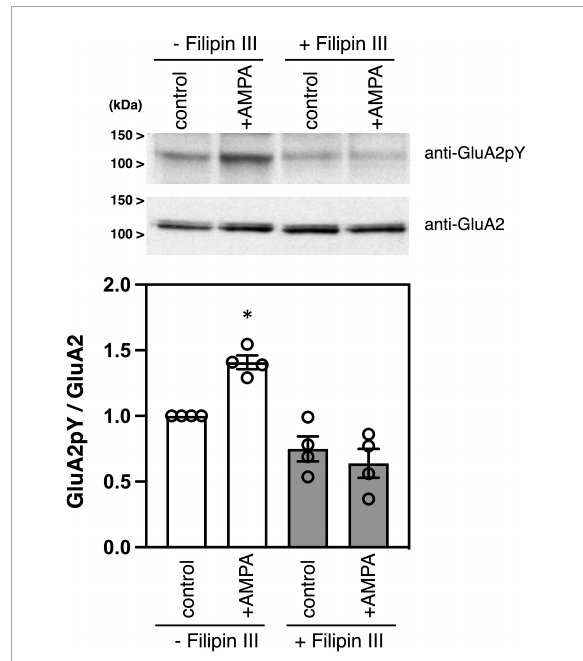
FIGURE2 Effects of filipin III treatment on AMPA-induced tyrosine phosphorylation of GluA2 in cultured cortical neurons. Cultured cortical neurons were treated with DMSO or 10 µ g/ml Filipin III for 10 min, followed by stimulation with 100 µ M AMPA for 10 min. Cell lysates from cultured cortical neurons were immunoblotted with anti-GluA2CpY or anti-GluA2 antibodies to quantify tyrosine phosphorylated GluA2 and GluA2 protein expression. Typical blots as representatives are shown (Top) . The ratio of tyrosine phosphorylated GluA2 to GluA2 protein amounts is statistically analyzed (Bottom) . Error bars represent SEM. ∗ p < 0.05, compared with